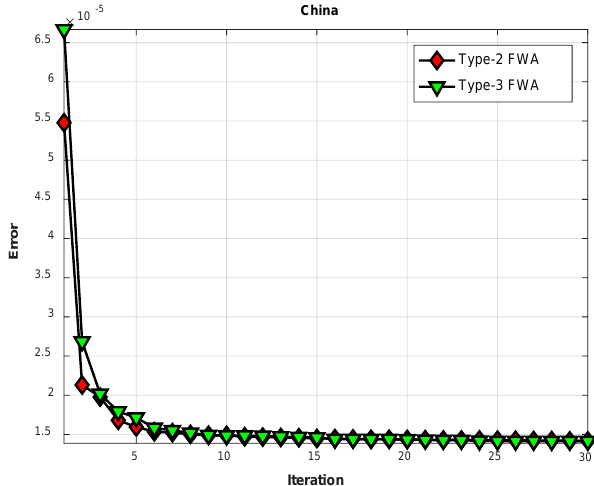
Figure 18. Type-3 fuzzy input variables (China): ( a ) fuzzy input #1; ( b ) fuzzy input #2; ( c ) fuzzy input #3.